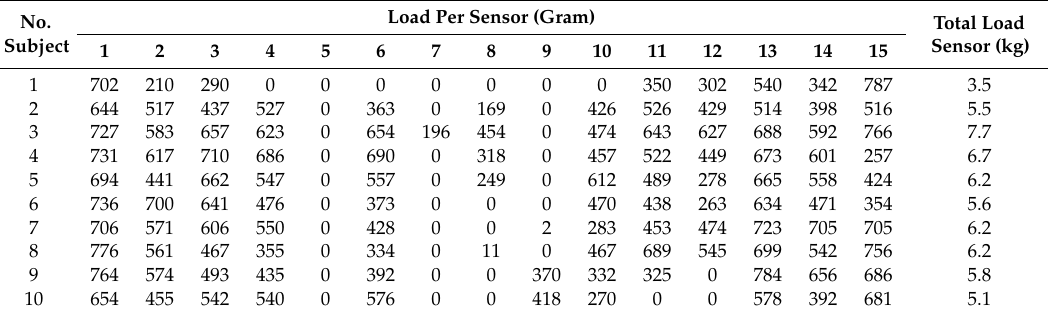
Table 3. Load data on the soles of left leg 10 research subjects.